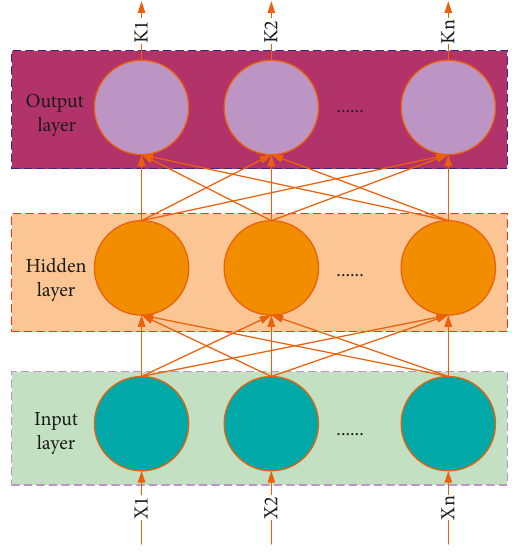
Figure 6: Forward neural network